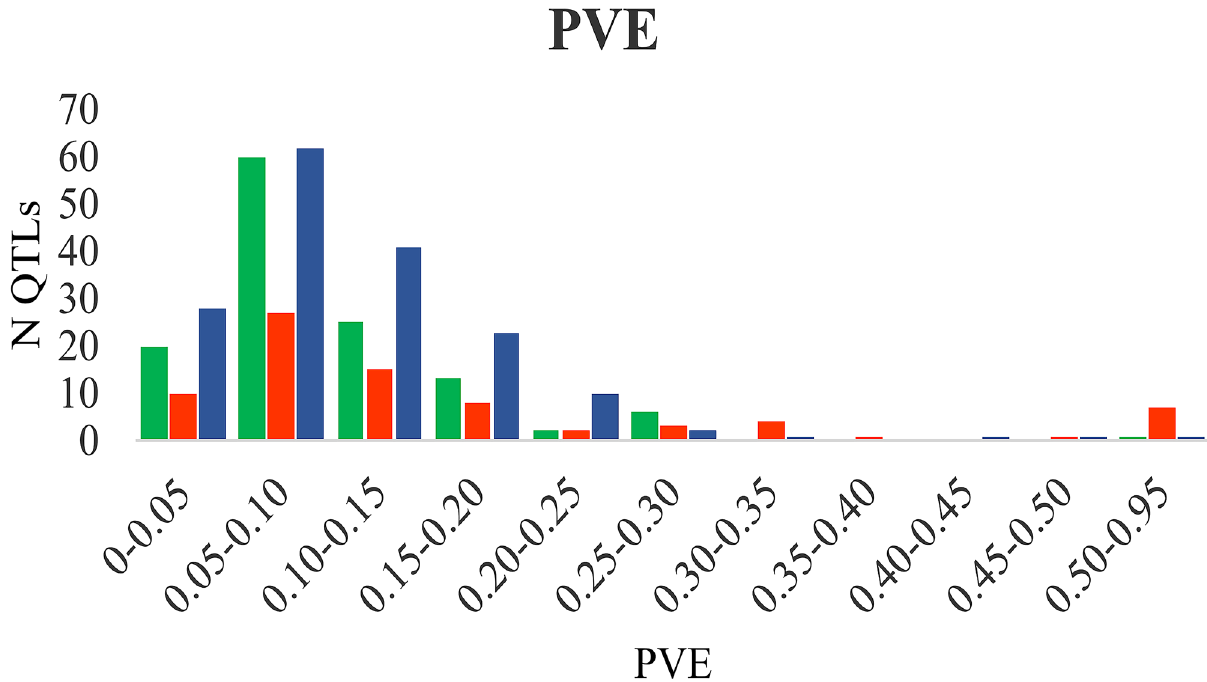
Figure 2. Phenotypic variance explained by original QTL. Colour code: green: abiotic stress QTL; orange: biotic stress QTL; blue: quality QTL.